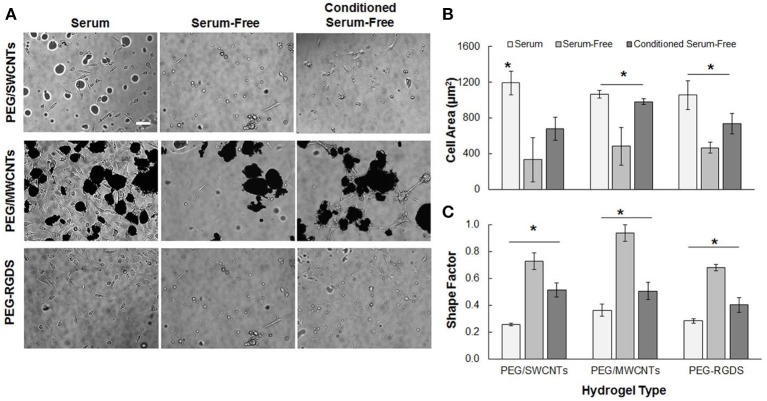
(A) Phase contrast images of NIH 3T3 cells on PEG/SWCNTs, PEG/MWCNTs and PEG-RGDS hydrogels in serum, serum-free and conditioned serum-free medium (scale bar is 100 μm). (B) Cell spreading area and (C) cell shape factor (inverse of elongation) for NIH 3T3 cells on PEG/SWCNTs, PEG/MWCNTs and PEG-RGDS hydrogels in serum, serum-free and conditioned serum-free medium. *Asterisks designate significant differences (120 cells from n = 3, p < 0.05).